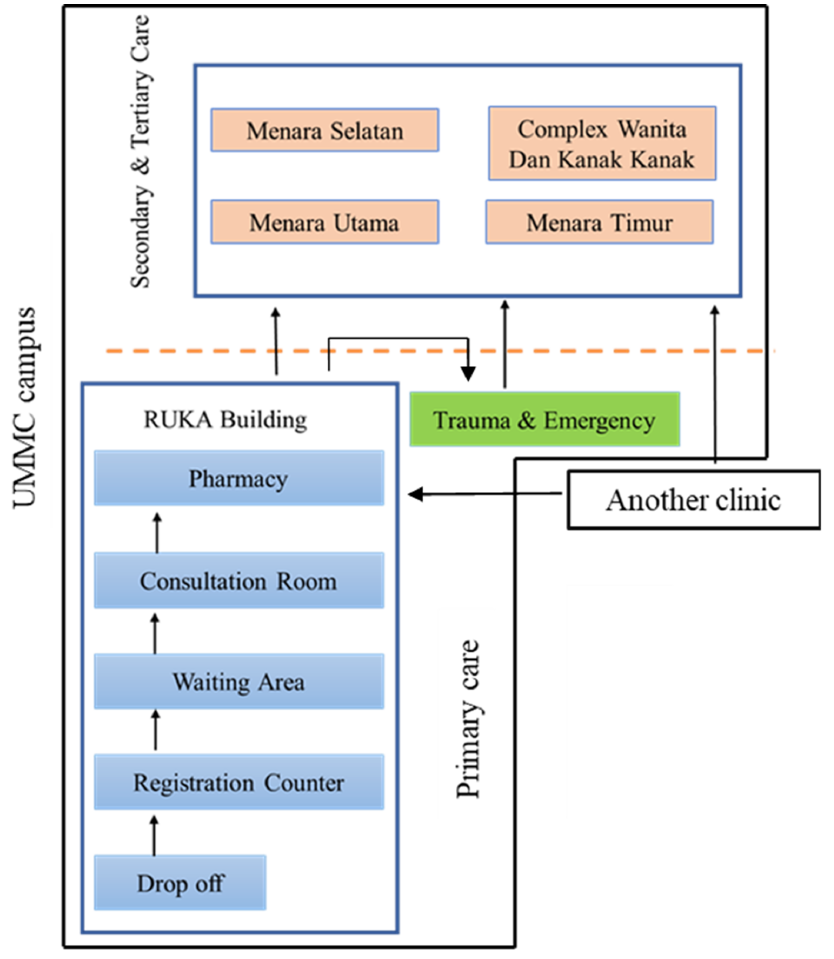
Figure 2. The UMMC treatment and referral system [34]. RUKA, the trauma and emergency area, areas highlighted as primary care areas, and secondary and tertiary care areas are all separate buildings on the UMMC campus.